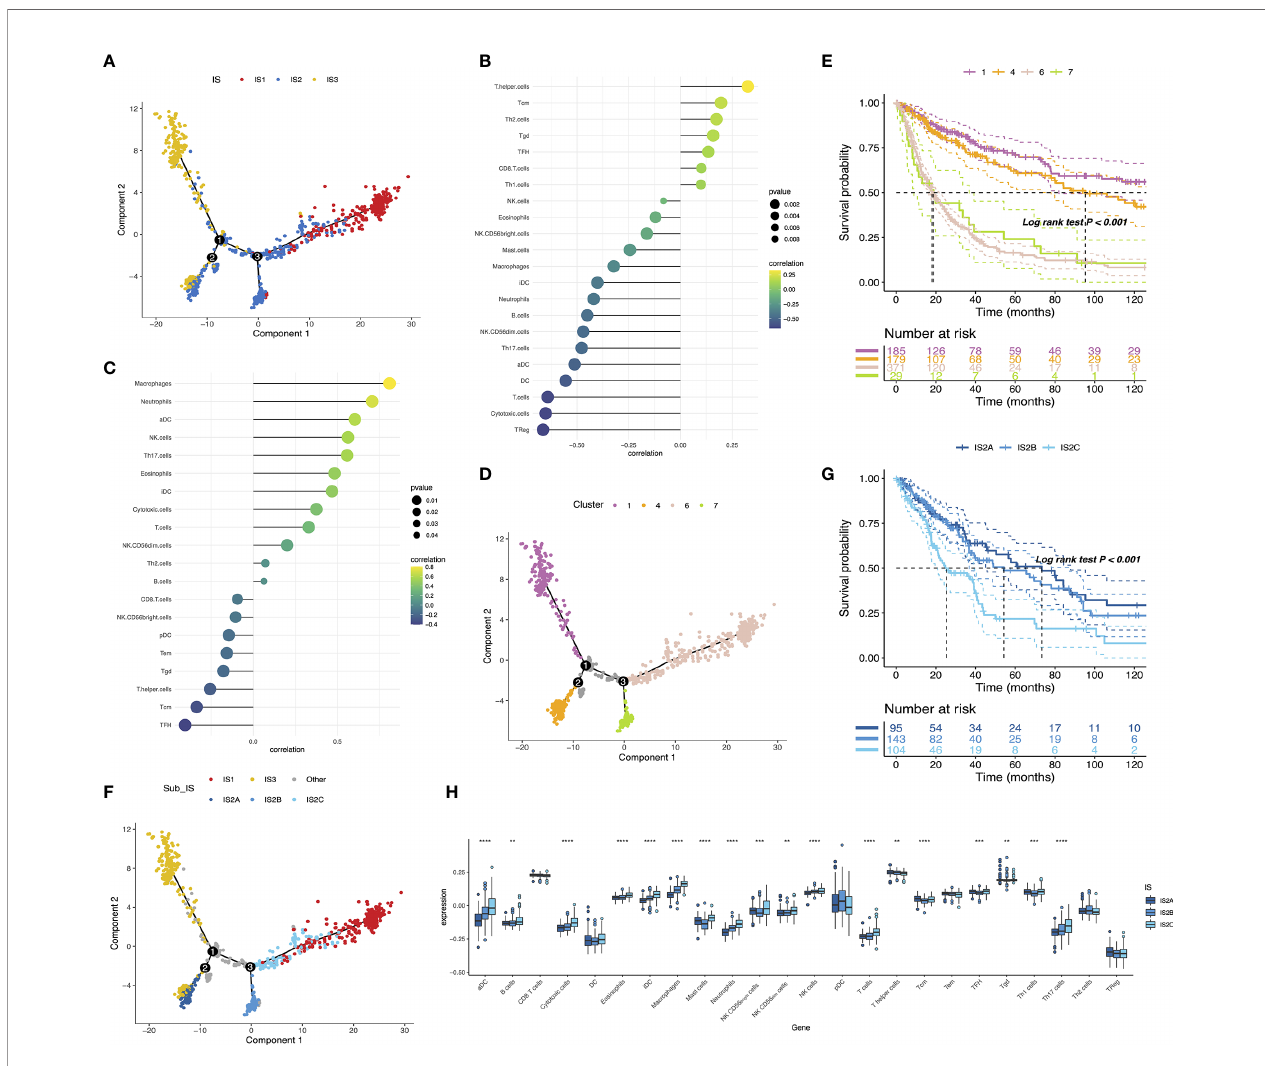
FIGURE 8 | The immune landscape of glioma (A) . Each point represents a patient and the immune subtypes are color-coded. Signi fi cant correlation of PC1 (B) and PC2 (C) with immune cell signatures. The immune landscape of samples from four extreme locations (D) and their prognoses (E) . The immune landscape of the subsets of glioma immune subtypes (F) . Different groups in IS2 are associated with different prognostic statuses (G) . Differential enrichment scores of 24 immune cell signatures in the IS2A-C subsets (H) . **p < 0.01, ***p < 0.0001, and ****p <